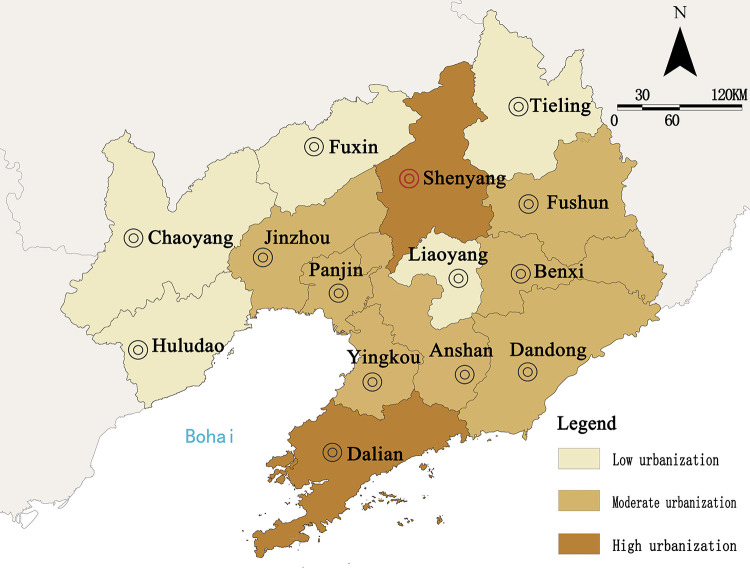
The spatial distribution of urbanization quality in Liaoning Province from 2009 to 2019 (source of base map: The open source map data service provided by the National Platform for Common GeoSpatial Information Services (https://www.tianditu.gov.cn/)).